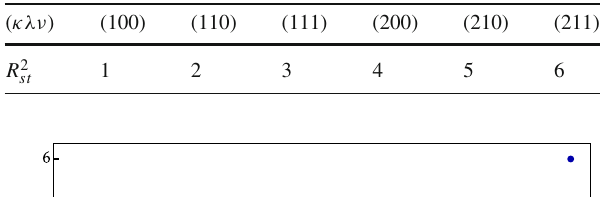
≤ 6 corresponding to Eq. (2.32) for Fig. 1 Plot of the mass ratios R 2 nil κ = 1 (blue) and κ = 2 (orange) N 3 for Table 3 The first few mass ratios R 2 st for the standard 3D torus T 3 , corresponding to Eq. (2.33)